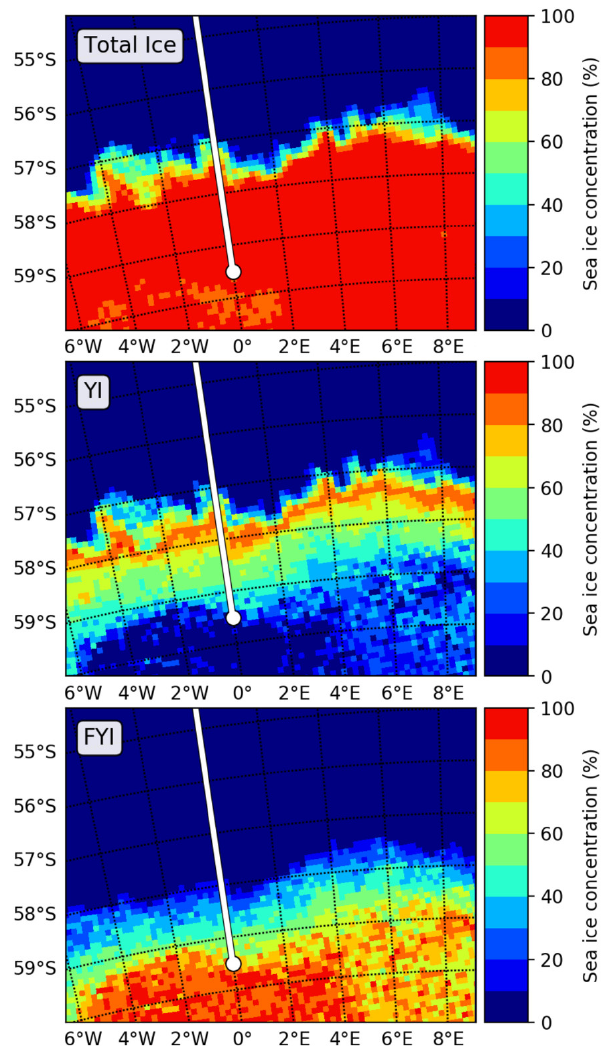
Figure 2. Sea ice type concentration data provided by the Univer- sity of Bremen. Daily concentration of total ice, young ice (YI) and first-year ice (FYI) on 24 July 2019 prior to the ship entering the MIZ. The cruise plan and the southernmost station (MIZ3A) are also shown. Data are available at https://seaice.uni-bremen.de/ sea-ice-concentration/amsre-amsr2/ (last access: 24 July 2019).